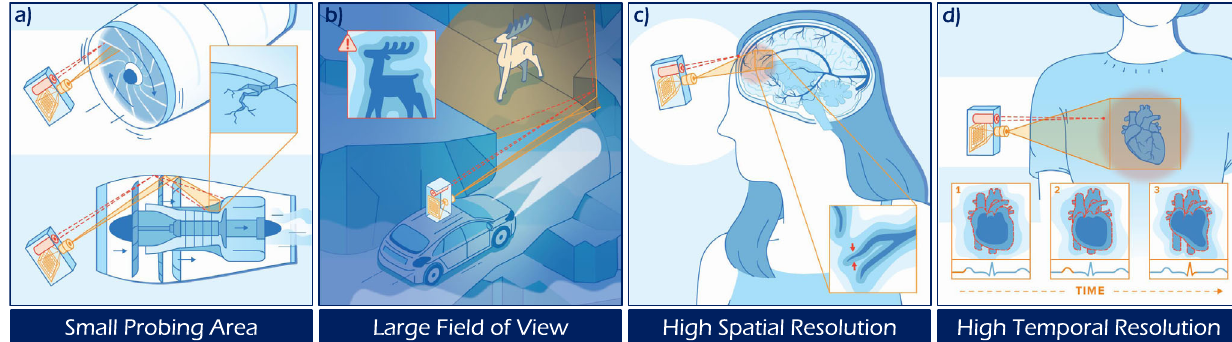
Fig. 6 Key attributes and potential future applications of SWH. The SWH approach combines four key attributes highlighted in the following potential future NLoS application scenarios: in each example, a scattering surface or medium is used to indirectly illuminate, and intercept light scattered by the hidden objects. a A small probing area allows to inspect defects in tightly con fi ned spaces, e.g., in running aircraft engines. b A wide angular FoV allows to measure/detect hidden objects without previous knowledge of their position as, e.g., important when navigating in degraded visual environments. c High spatial resolution allows for the measurement of small structures, such as non-invasive imaging of brain vessels through the skull. d High temporal resolution allows to image objects in motion, e.g., to discern cardiac arrhythmia through the chest. The integration of these attributes in a single approach to NLoS imaging distinguishes SWH from the current state of